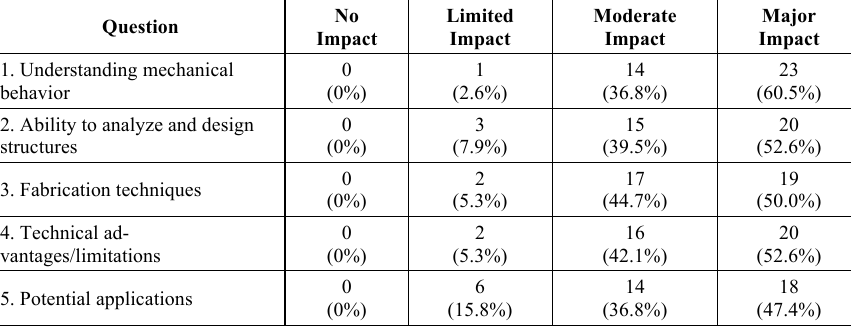
Table 3. Student learning outcomes survey results (post-OEDE laboratory exercise).